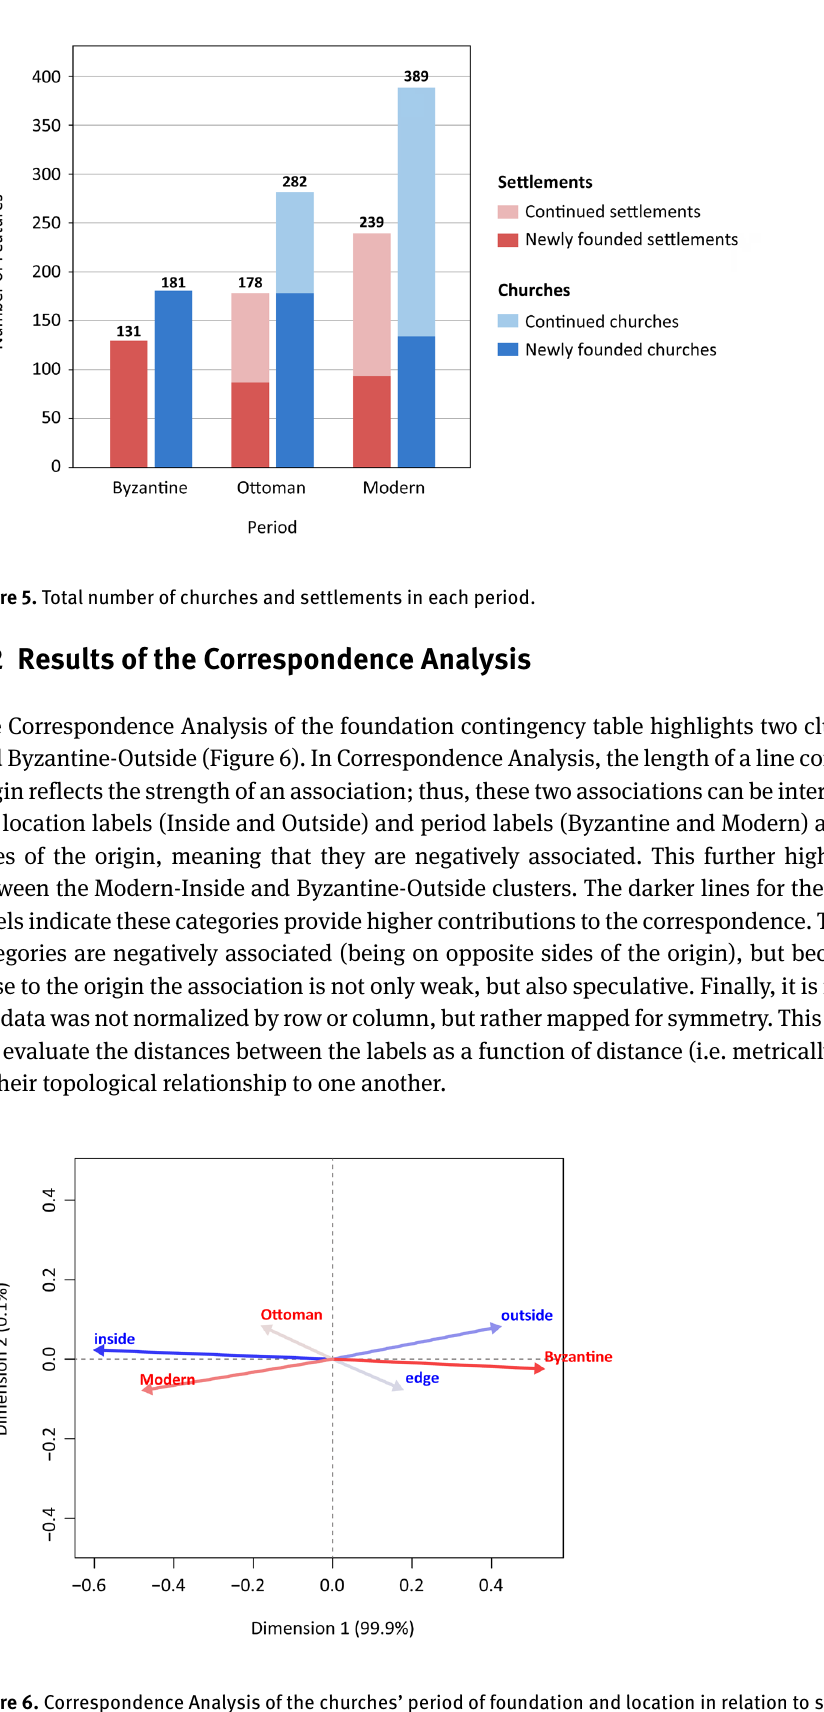
Figure 6. Correspondence Analysis of the churches’ period of foundation and location in relation to